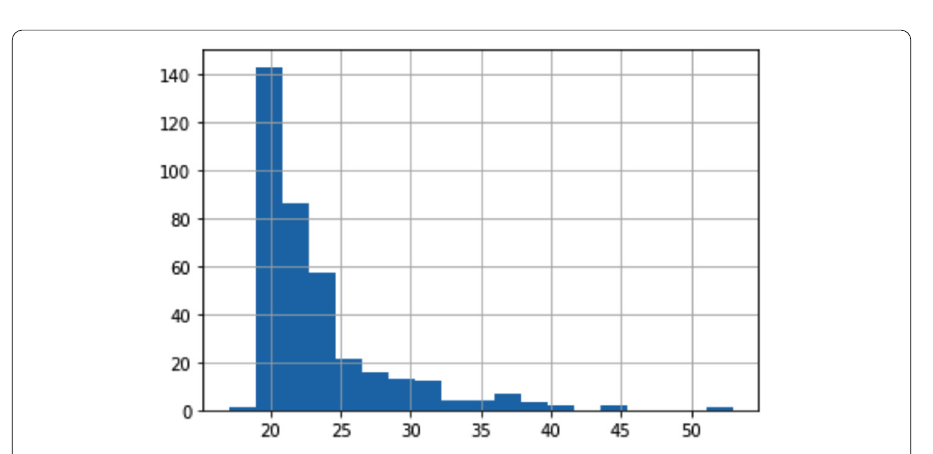
Figure 3 Distribution of Age values